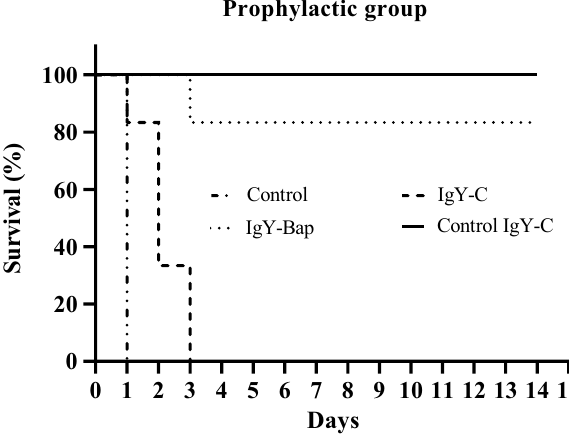
Figure 5. Mice survival rate followed up for 14 days after the challenge in the prophylactic mode. Control: The control group received only A. baumannii (Kh0060), IgY-C: Mice received control IgY (IgY-C) 1 h before inoculation with A. baumannii , IgY-Bap: Mice received IgY-Bap antibody before inoculation with A. baumannii , and Control IgY-C: Mice received only IgY-C antibody (no bacterial challenge).